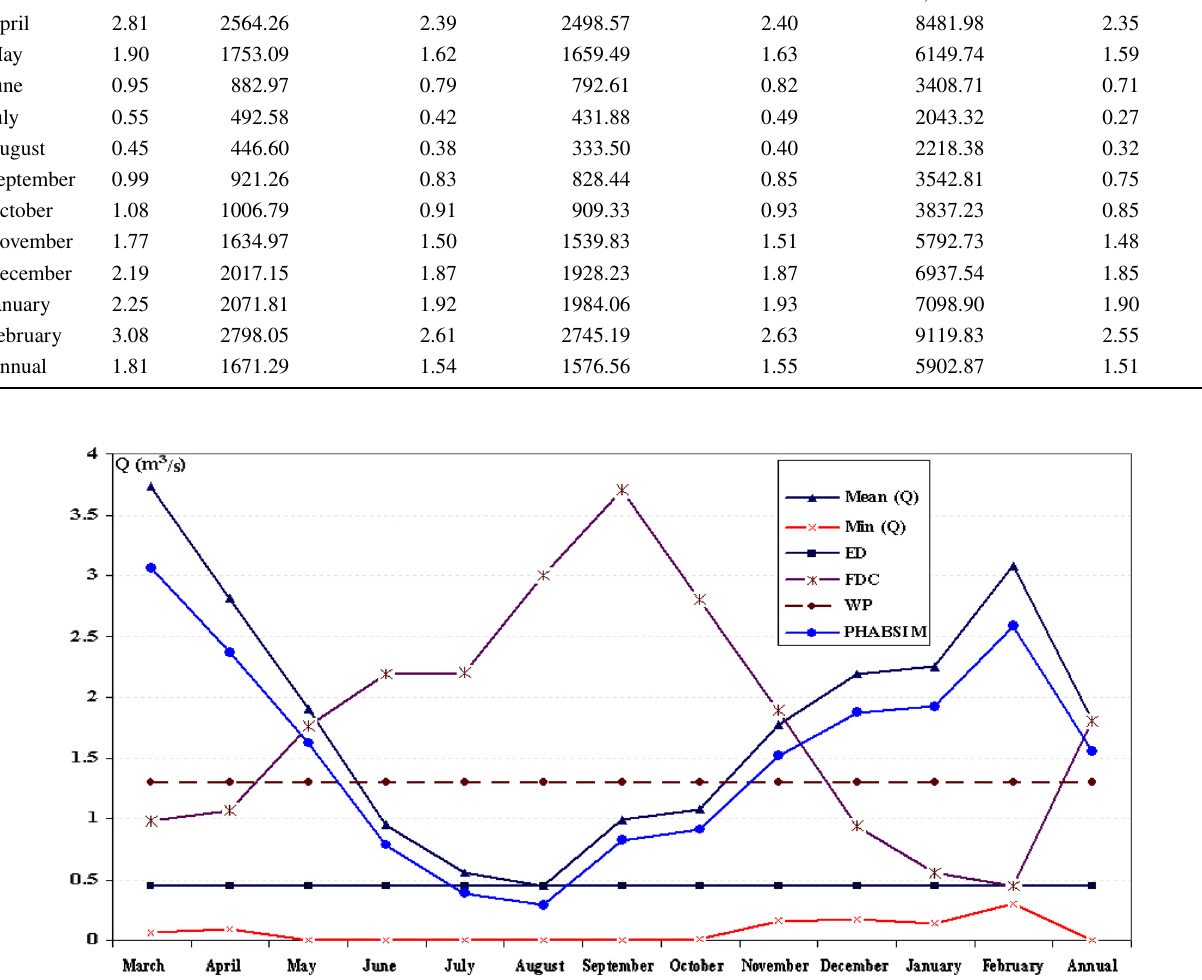
Fig. 10 The mean monthly and annual discharges of the Qarasu river and the estimated EWR using different methods. The Tenant method is not applicable to the rivers in this study Note: ED: Eco-deficit